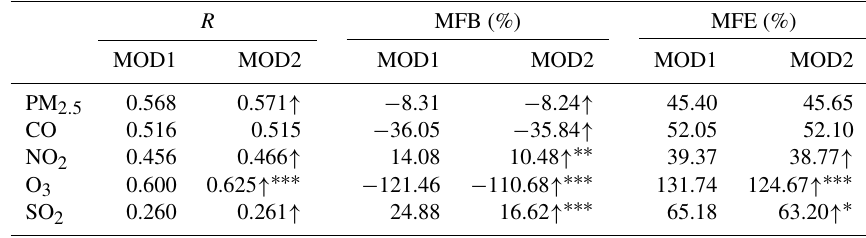
Table 3. Statistics comparing observed and simulated PM 2 . 5 , CO, NO 2 , O 3 , and SO 2 .